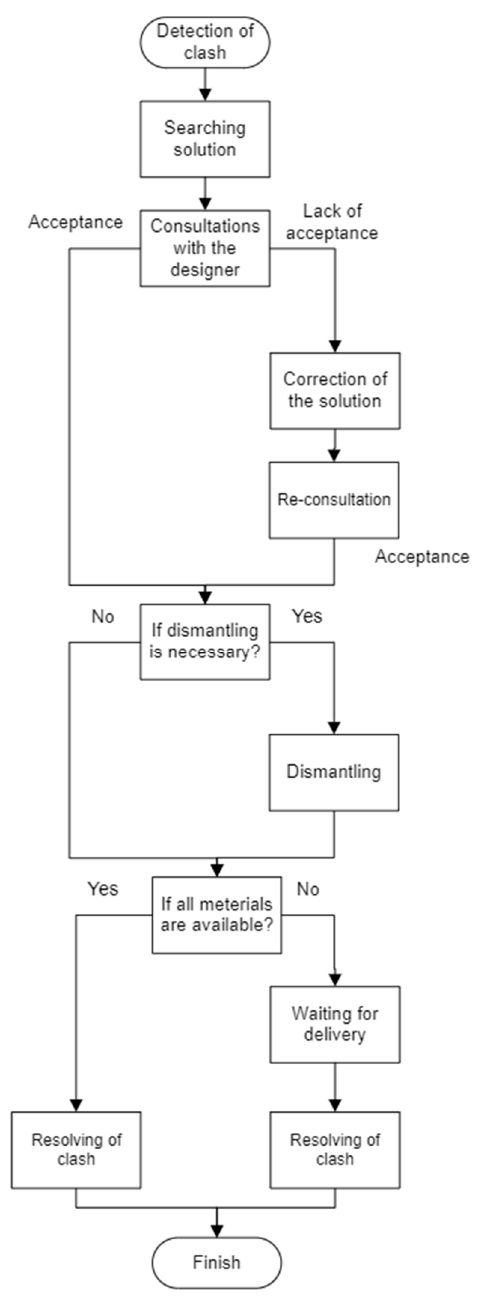
Figure 5. Medium clash